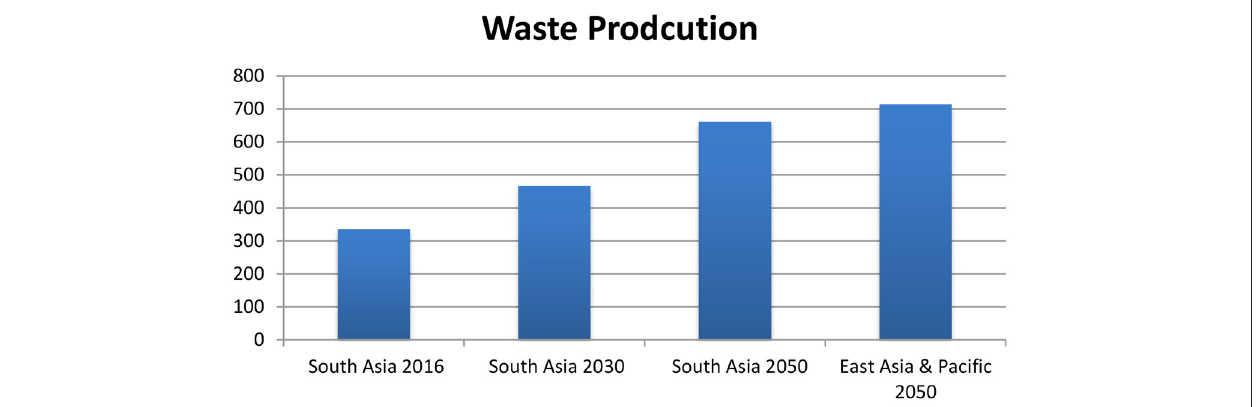
FIGURE 11 | Reproduced with the help of World Bank data